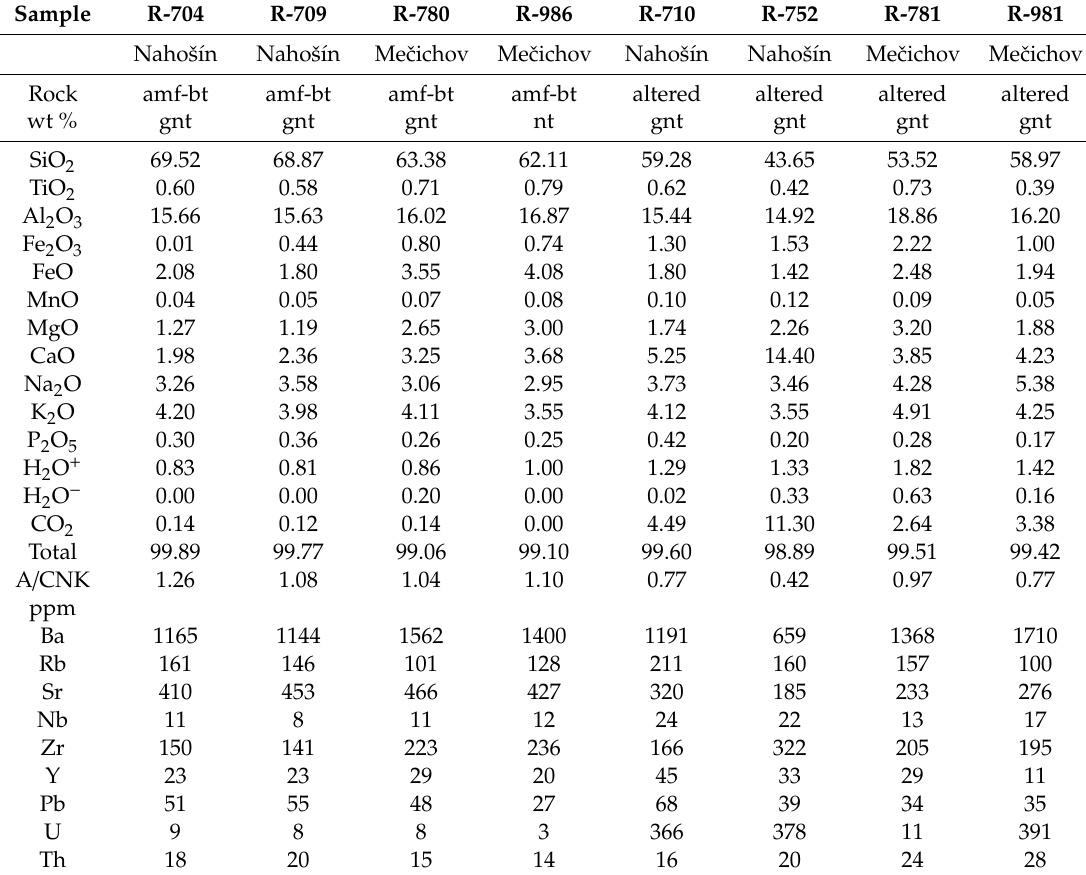
Table 1. Representative chemical analyses of rocks from the Nahoš í n and Meˇcichov uranium